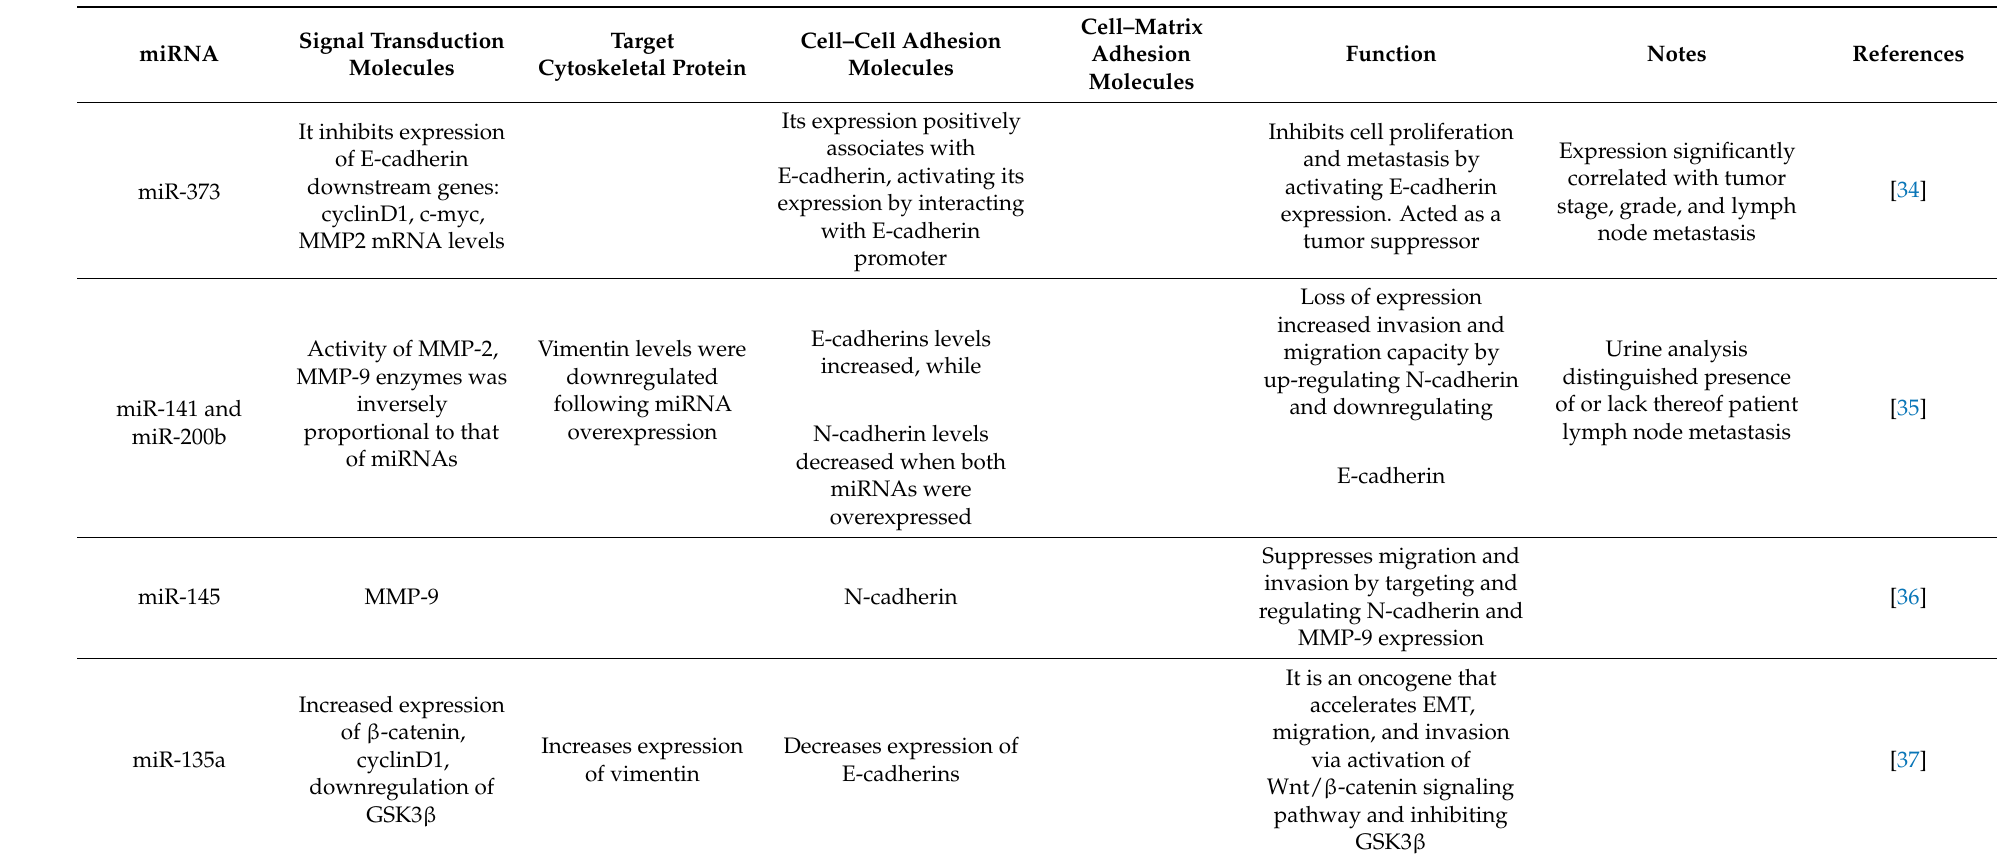
Table 1. Functions of miRNAs with CAMs in